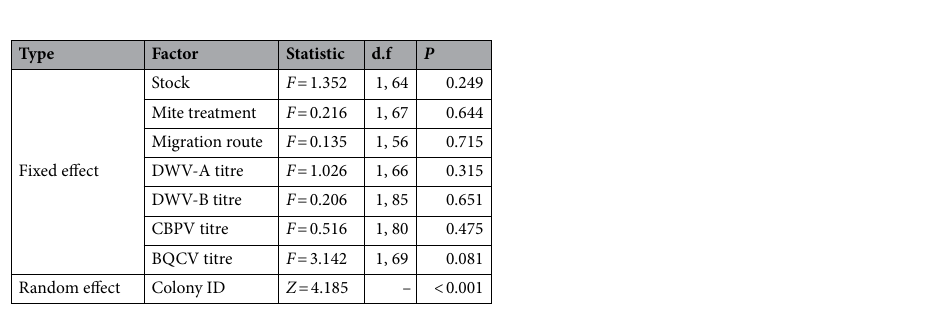
Table 2. Summary statistics for GLMM assessing the effect of viral titres on colony survival. d.f. are calculated via the Welch–Satterthwaite